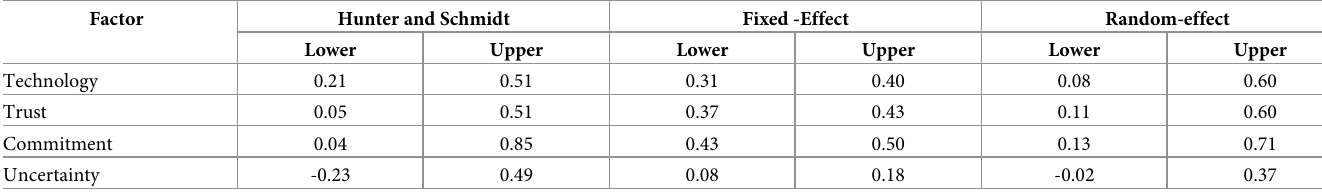
Table 8. Results of confidence interval in three